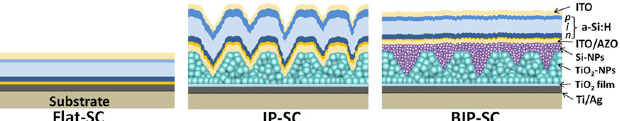
Fig. 2. The cross-sectional schematic illustrations of the n-i-p a-Si:H solar cells grown on Flat-BR (Flat-SC), IP-BR (IP-SC) and BIP-BR